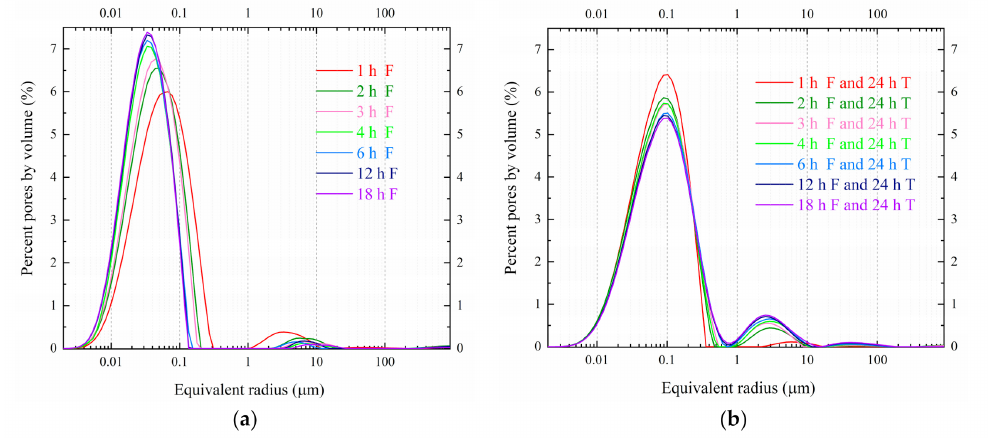
Figure 11. PSD after different freezing duration: ( a , b ) show the corresponding post-test results for the freezing duration initially and after a 24 h rest period.